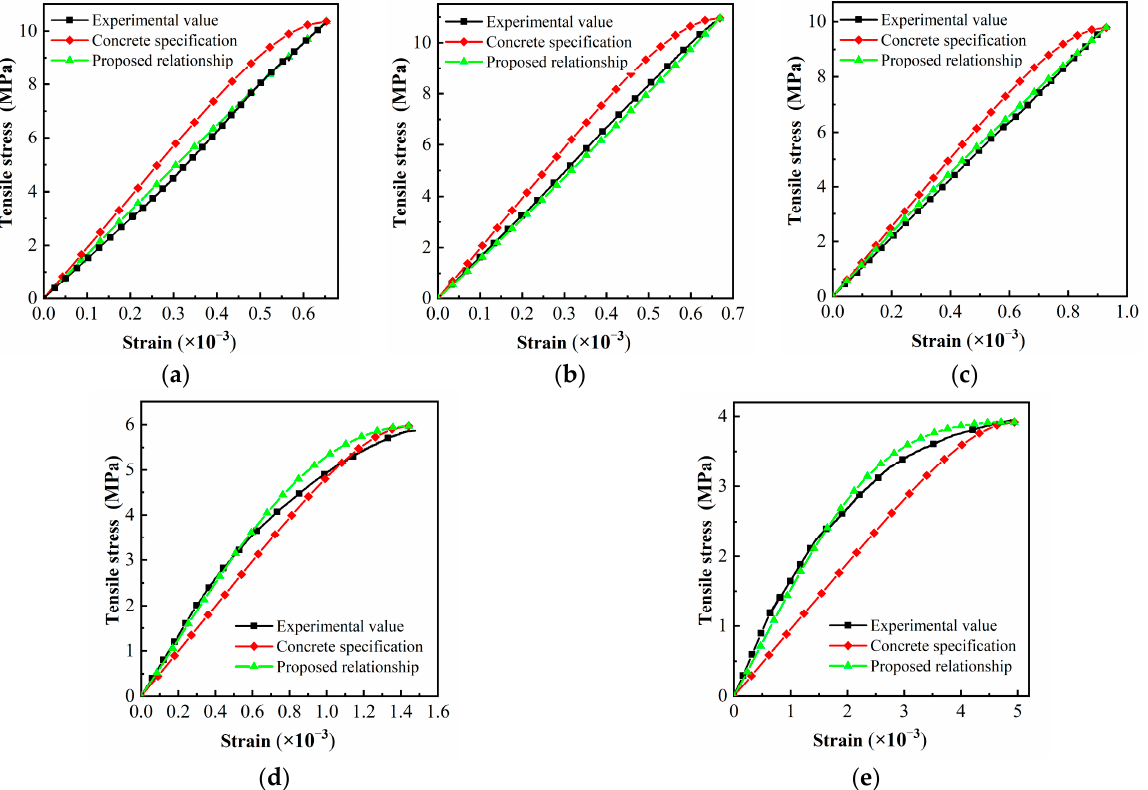
Figure 19. Comparison of tensile constitutive models. ( a ) − 10 °C, ( b ) 0 °C, ( c ) 15 °C, ( d ) 40 °C, ( e ) 60 °C.